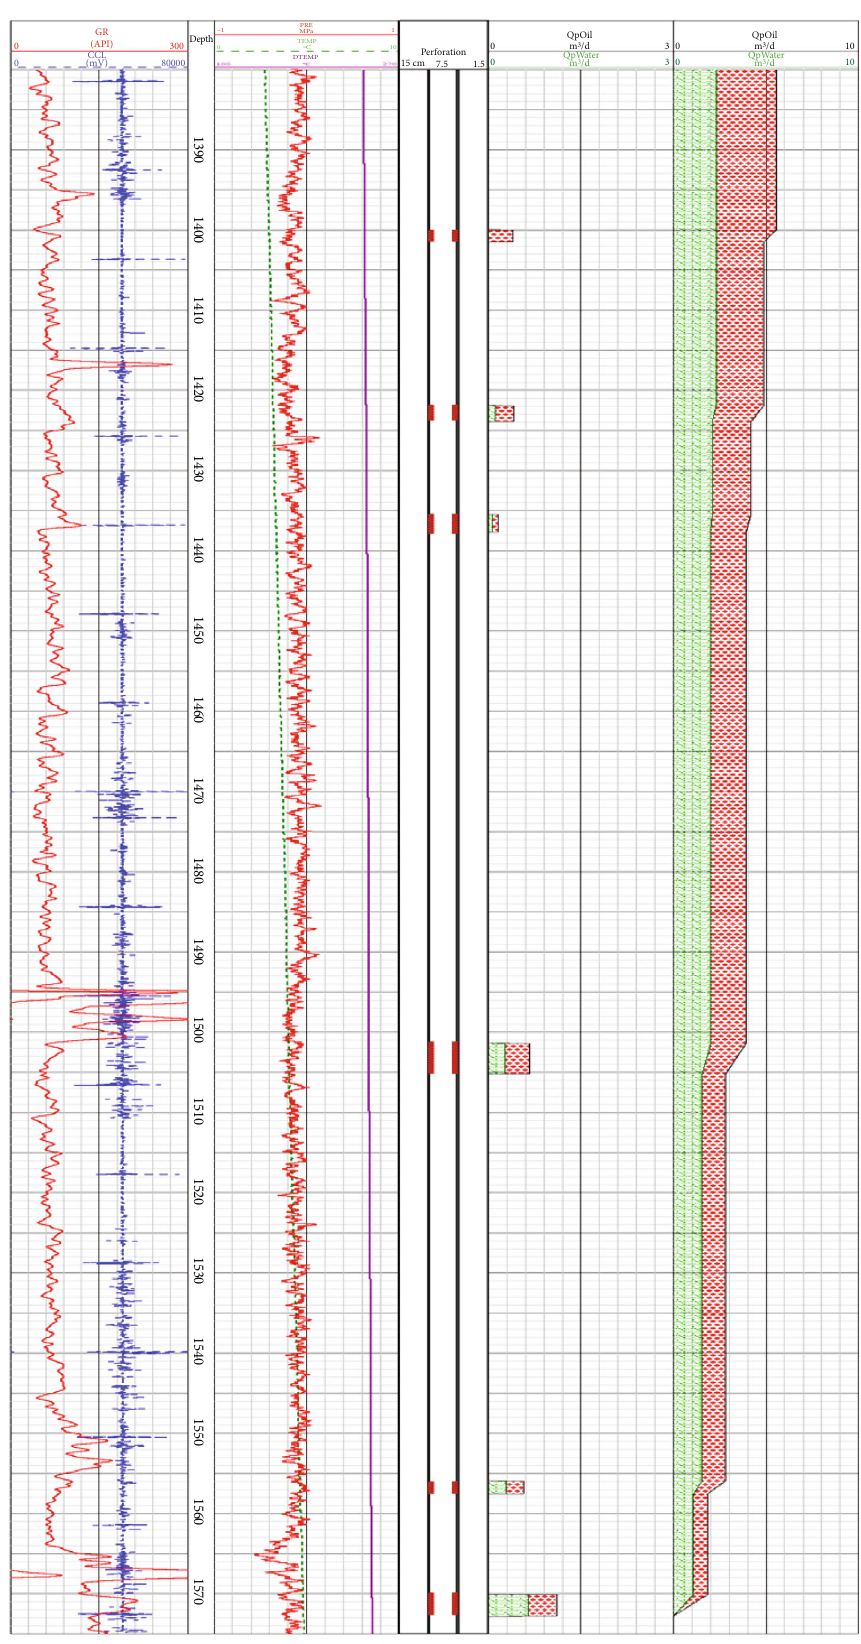
Figure 13: Interpretation results of well